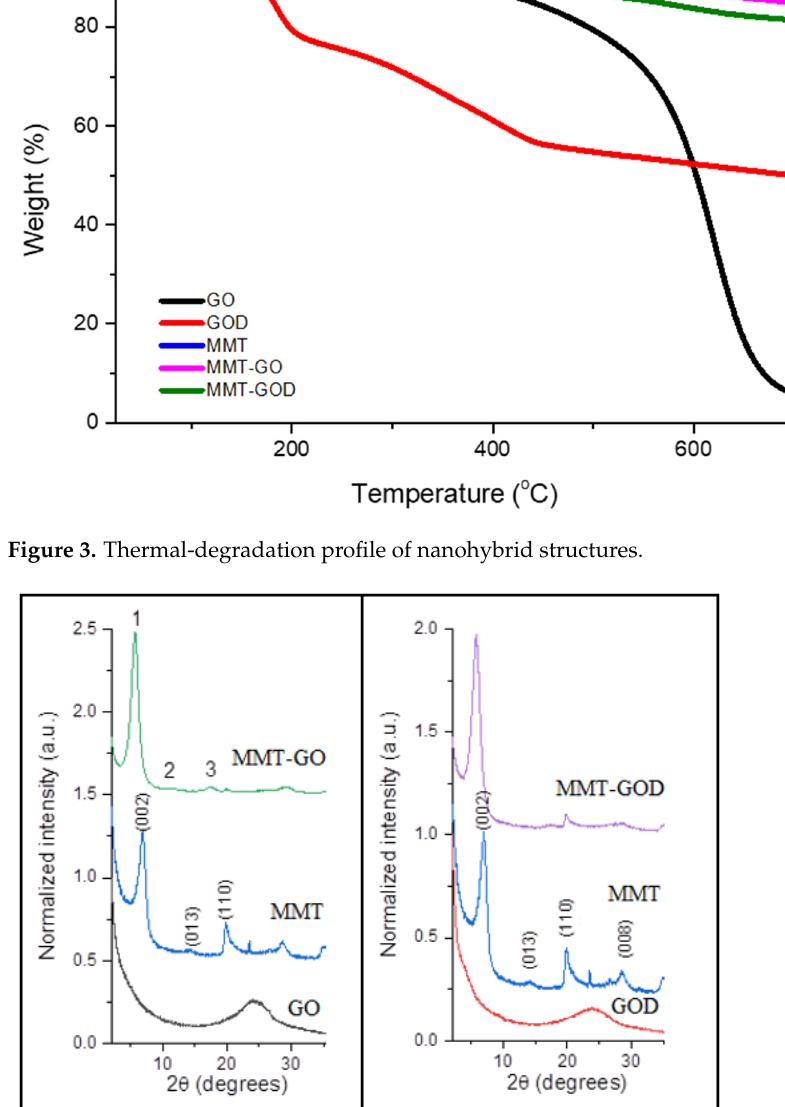
Figure 4. X-ray diffraction patterns for GO, GOD, MMT, MMT–GO and